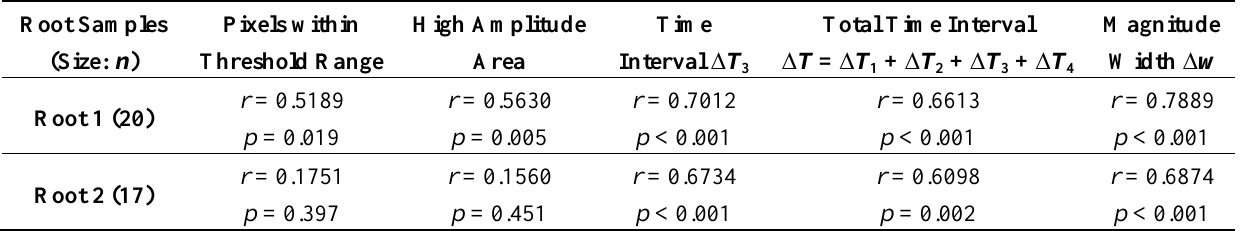
Table 3. Correlation coefficient ( r ) between the true root diameter and the extracted GPR indexes from root 1 and 2